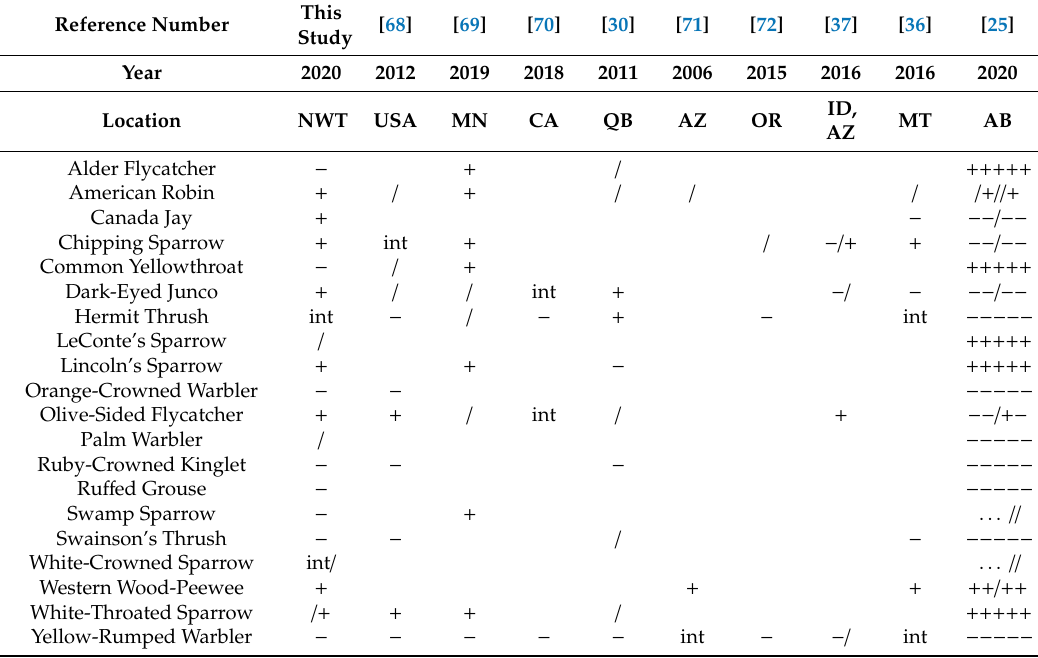
Table 3. E ff ects of burn severity on species included in our study and reported by other studies in North America. A “ + ” symbol indicates an increase in bird abundance with fire severity, a “ − ” indicates a decrease with severity / indicates no response to severity, “int” indicates an intermediate response (i.e., quadratic) to severity. Blank cells indicate the species was not observed in that study. The results from Alberta [25] are not response to severity, but indicate whether the species is more likely to be found in younger forests post-fire in 5 major vegetation types in boreal Alberta. Two symbols indicate that two or more vegetation types or spatial locations were compared within a study and showed di ff erent responses. “.” indicates the vegetation type was not used by a species. Location abbreviations are: NWT = Northwest Territories, Canada; MN = Minnesota, USA; CA =